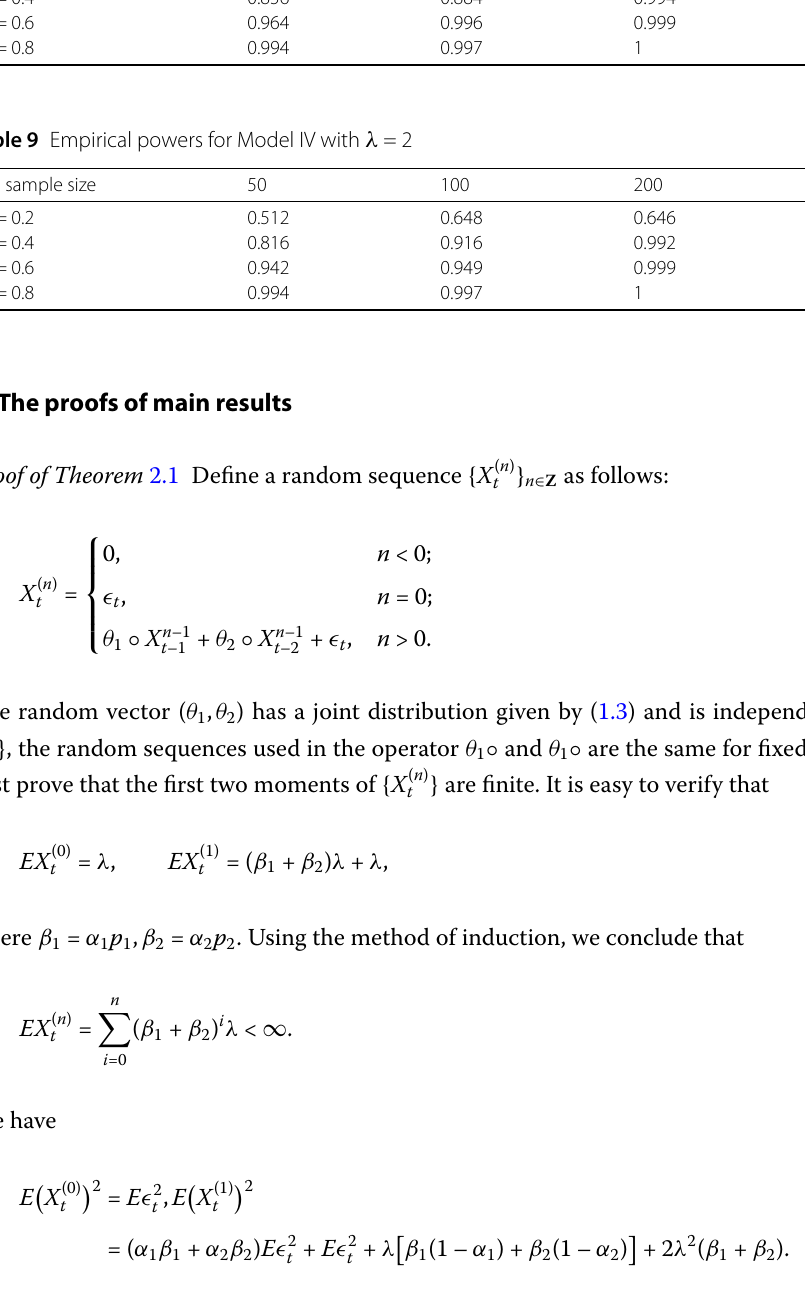
Table 8 Empirical powers for Model IV with λ = 1 α 2 \ sample size 50 100 200 500 α 2 = 0.2 0.636